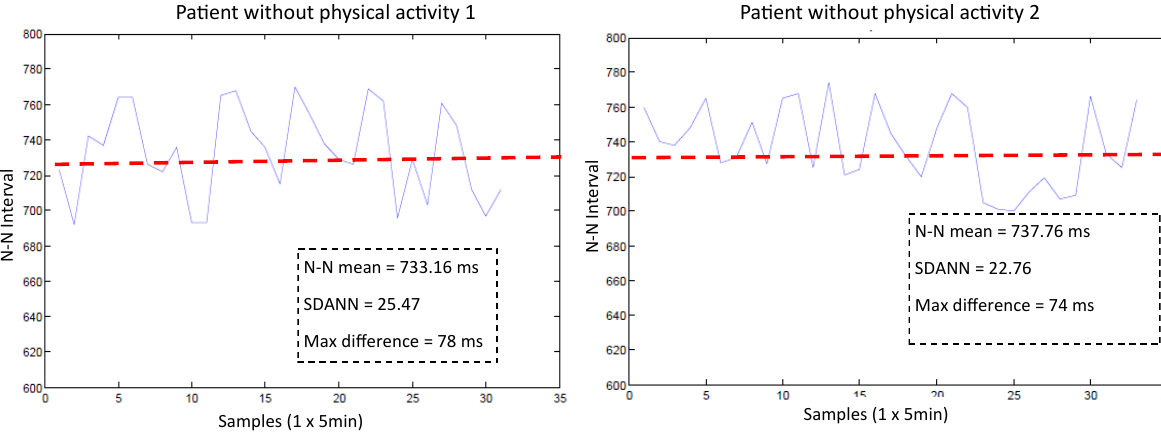
Figure 15. Tests of HR measurements in patients without previous physical activity. Patient without physical activity 1